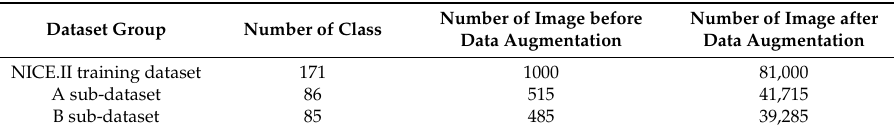
Table 3. Description of the experimental